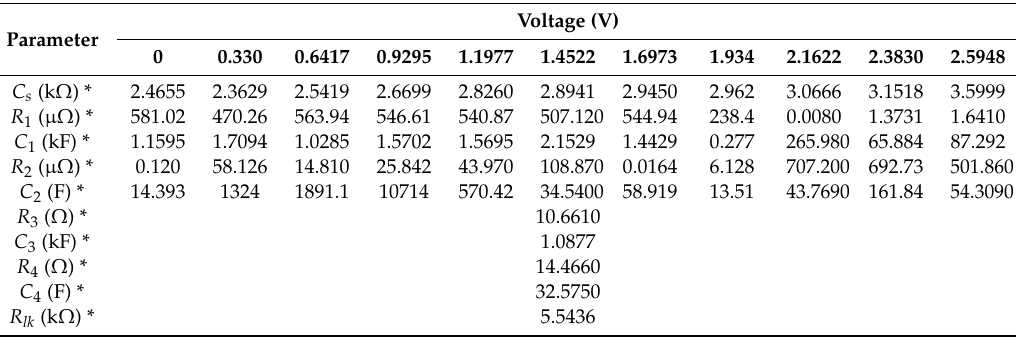
Table A3. Series Model Parameters with current profile i 2 .